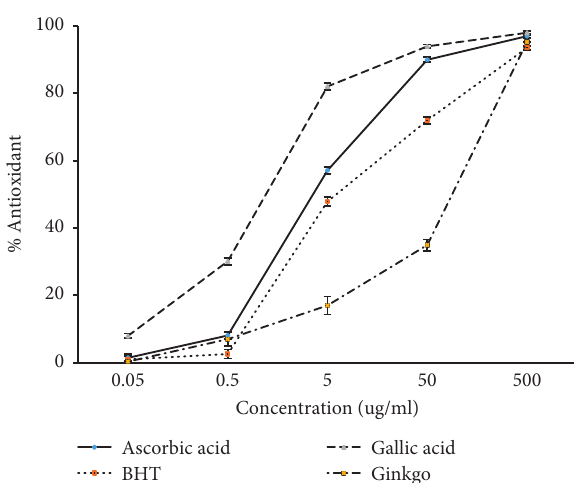
Figure 1: Antioxidant activity of G. biloba tea extract with different concentrations compared with that f positive controls ascorbic acid, BHT, and gallic acid (mean ± SD, n � 3).